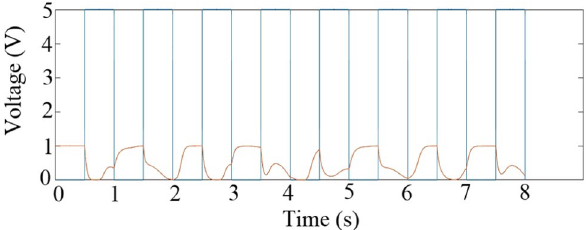
Fig. 9 Comparison of input message and decoded mes-